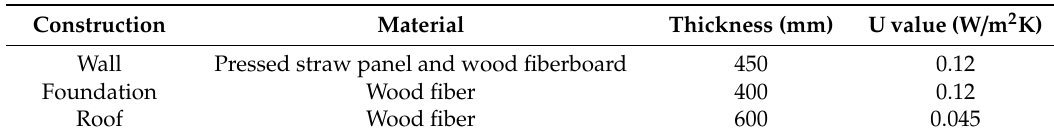
Table 1. The thermal properties of the constructions.